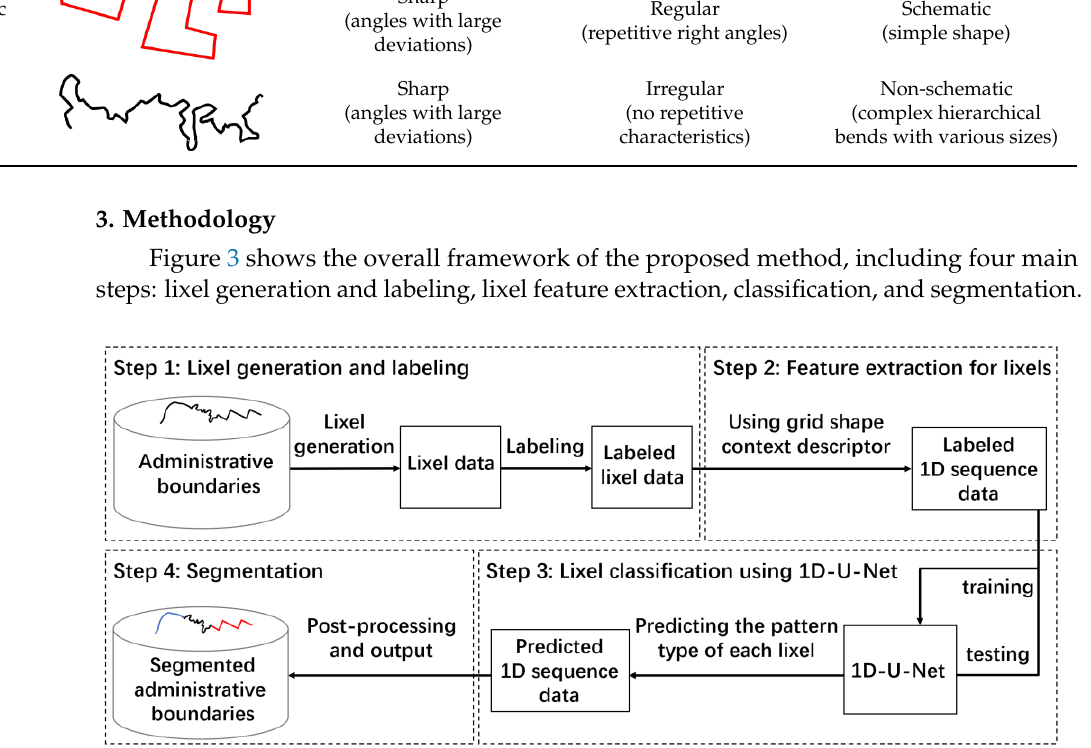
Figure 3. Framework of the segmentation method for administrative boundaries using the one-di- mensional convolutional neural network (1D-U-Net).